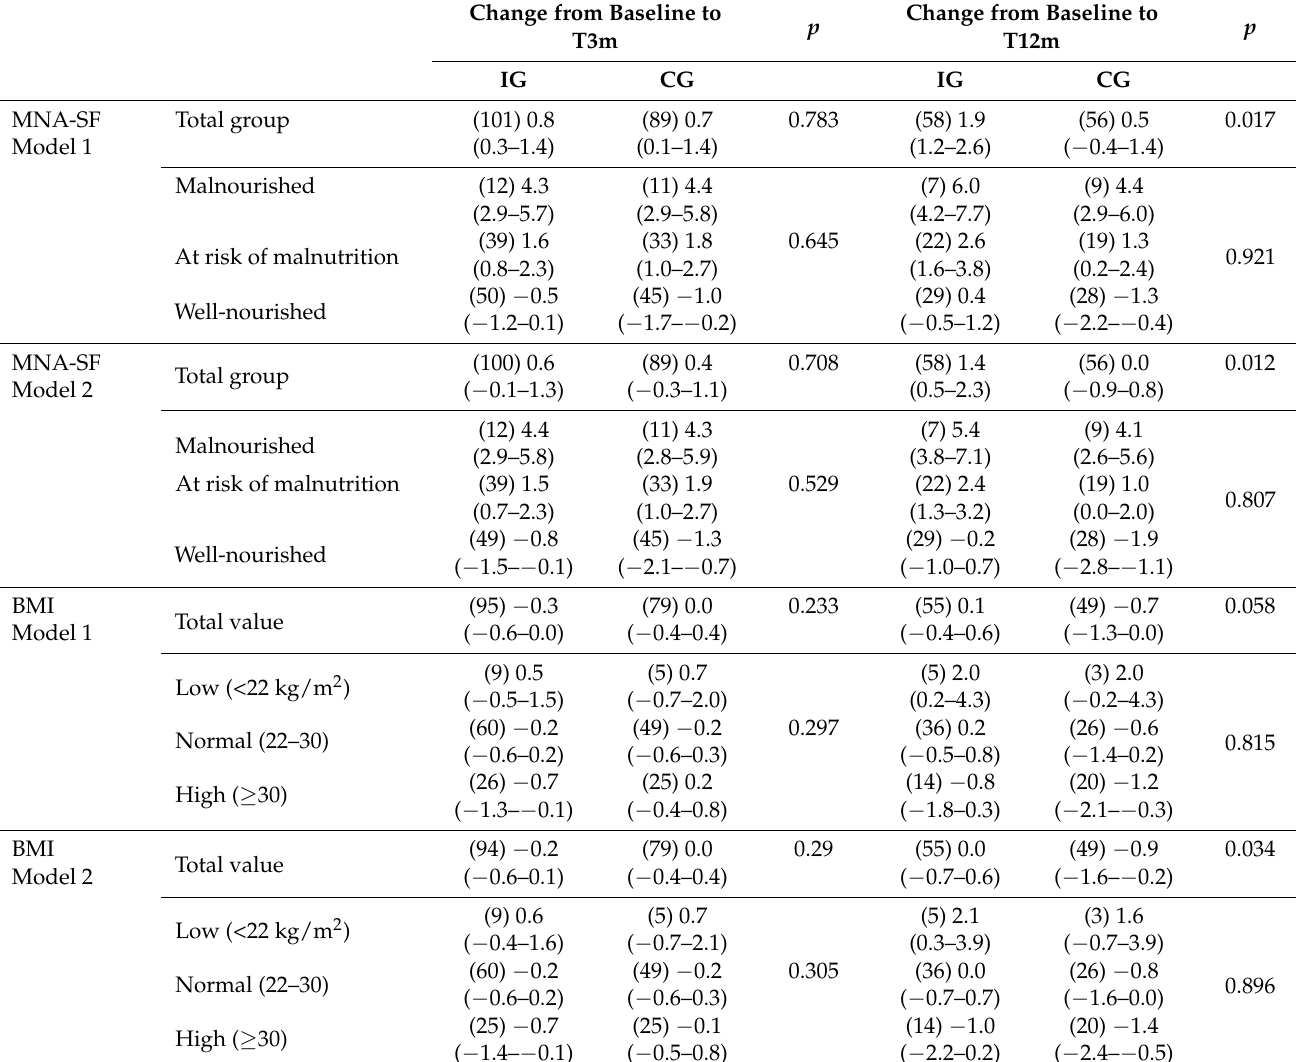
Table 3. Change in nutritional status after 3 and 12 months of intervention from baseline in the whole group and in baseline nutritional status categories ((number of participants) Estimated marginal means with 95% confidence